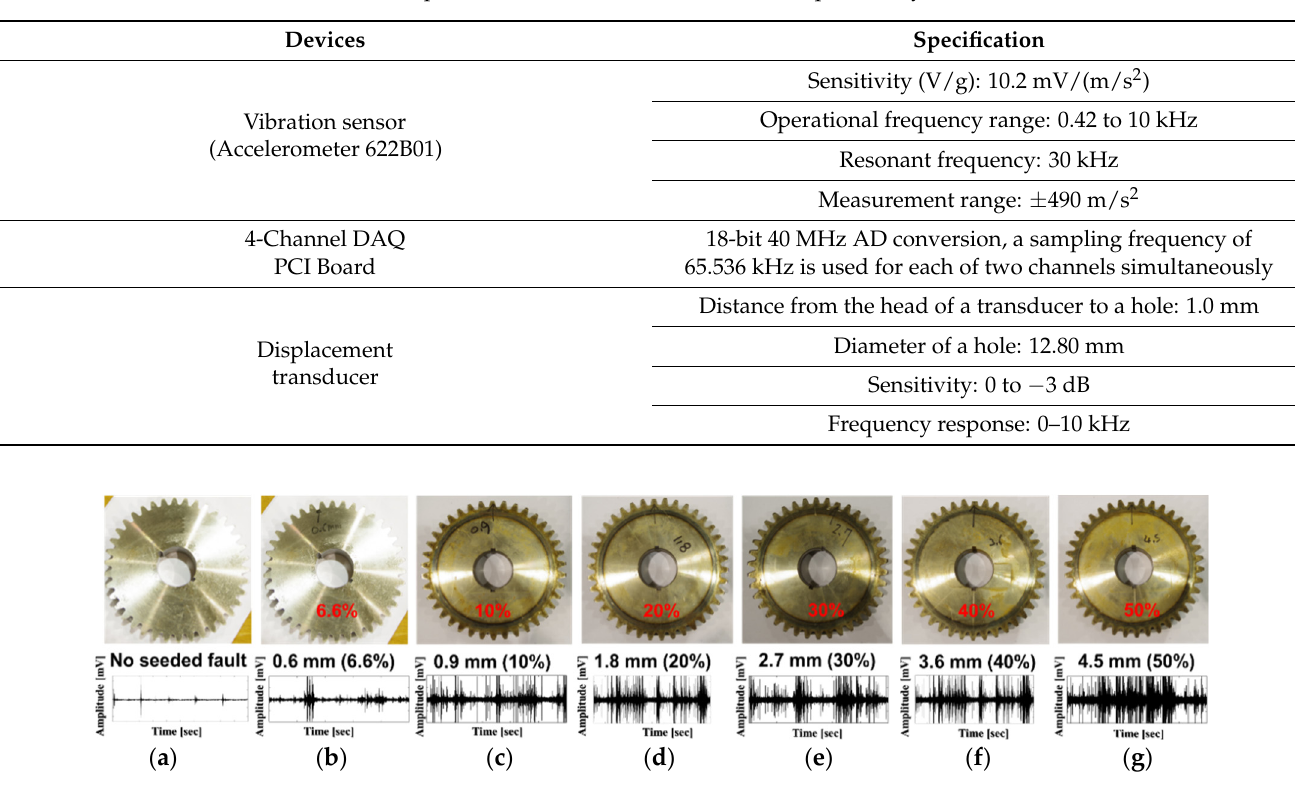
Table 1. Specifications of the sensors and data acquisition system.